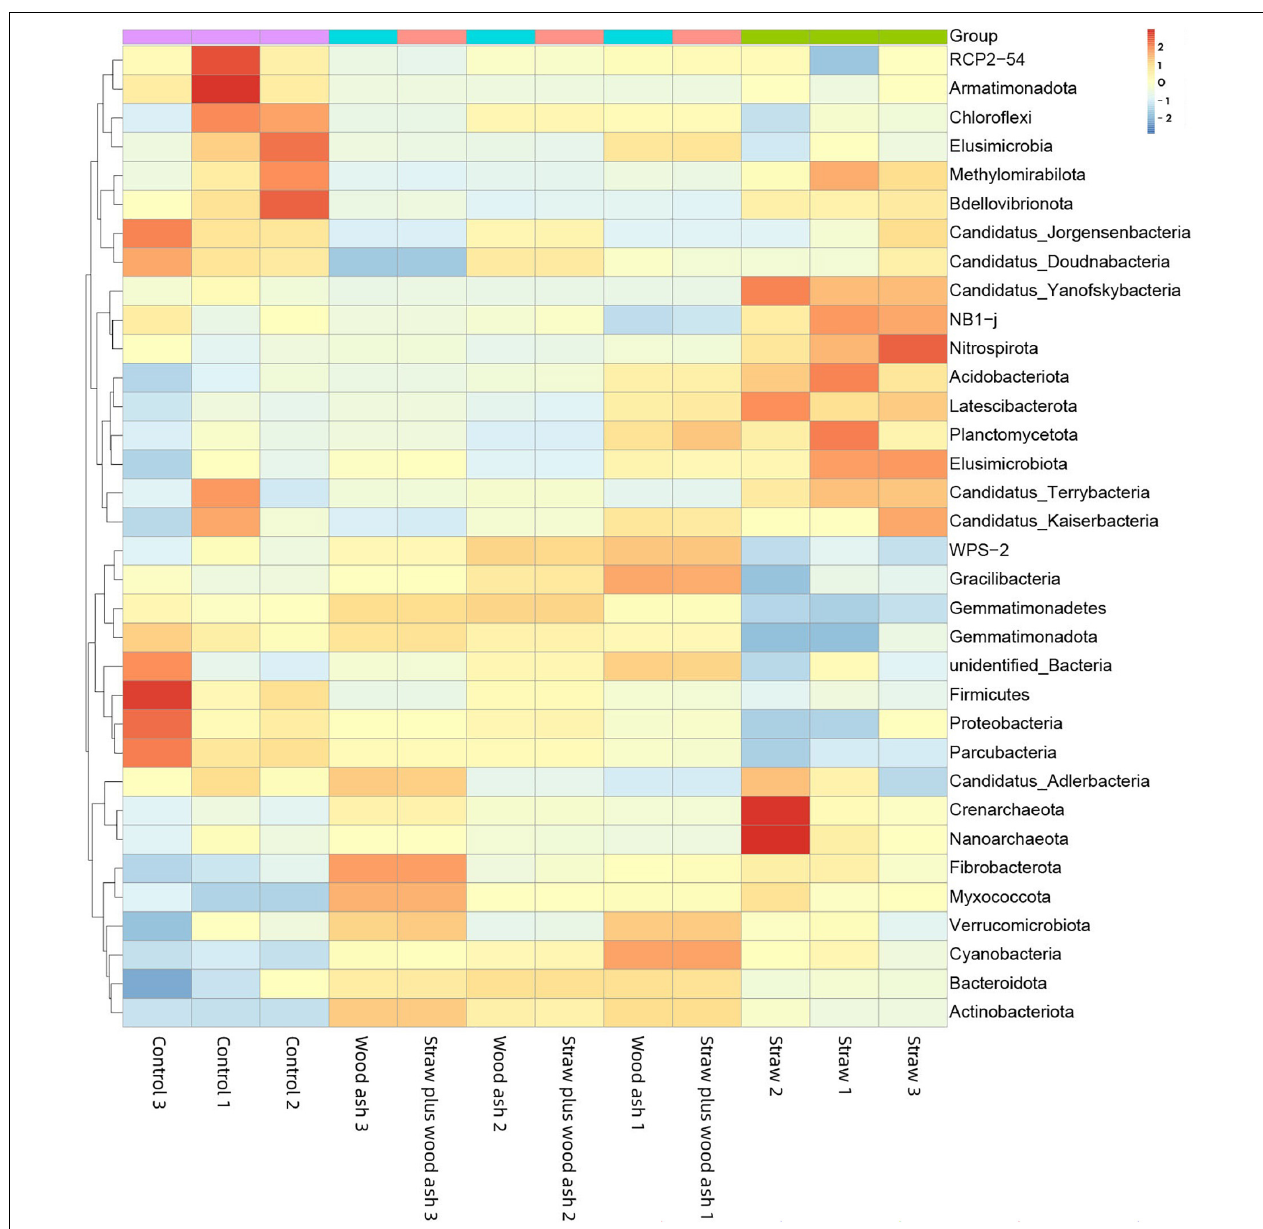
FIGURE 6 | Microbial community composition of top 50 abundant operational taxonomic units (OTUs) and their abundance level with cluster analysis. The dendrogram linkages and OTUs distances are not phylogenetic but based upon the reads number. The legend and scale represent the abundance of OTUs (Y-axis) within each sample (X-axis). The red indicates more abundant phyla and the blue represents less abundant phyla in the corresponding